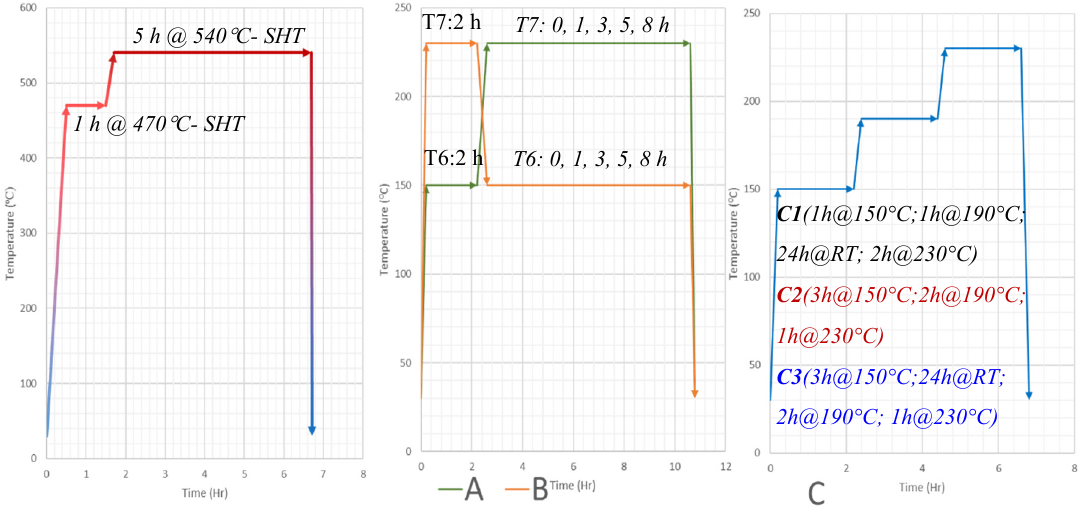
Figure 1. Accelerating thermal aging cycles; ( A ) T6 / T7 aging, ( B ) T7 / T6 aging, ( C ) multiple thermal aging cycles.